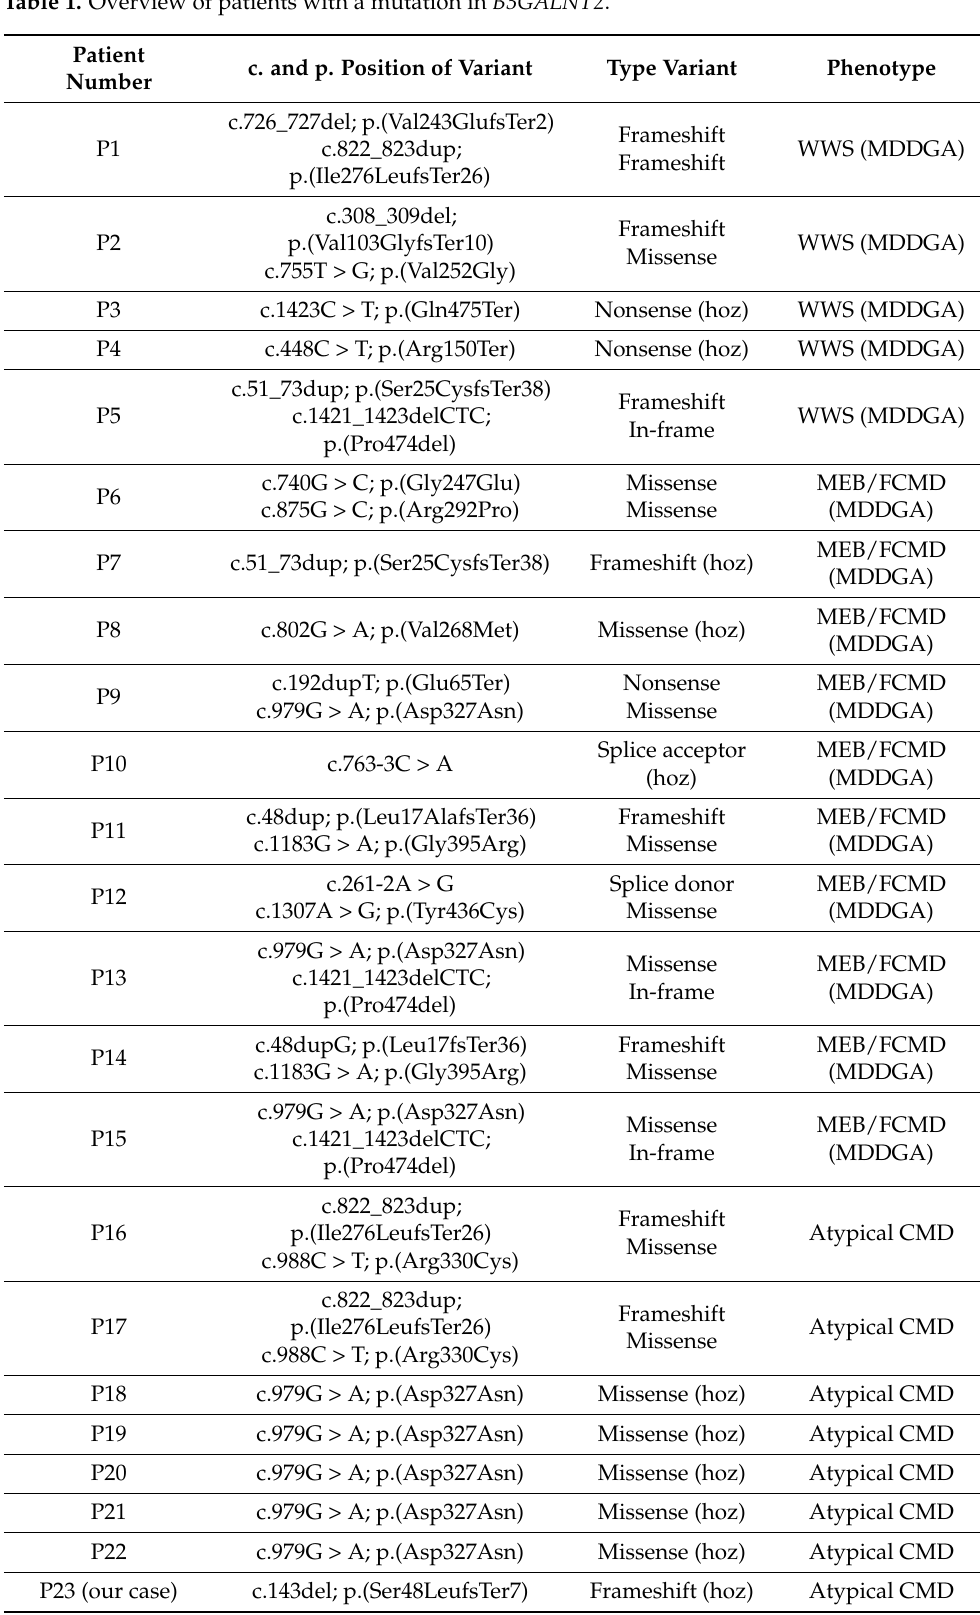
Table 1. Overview of patients with a mutation in B3GALNT2